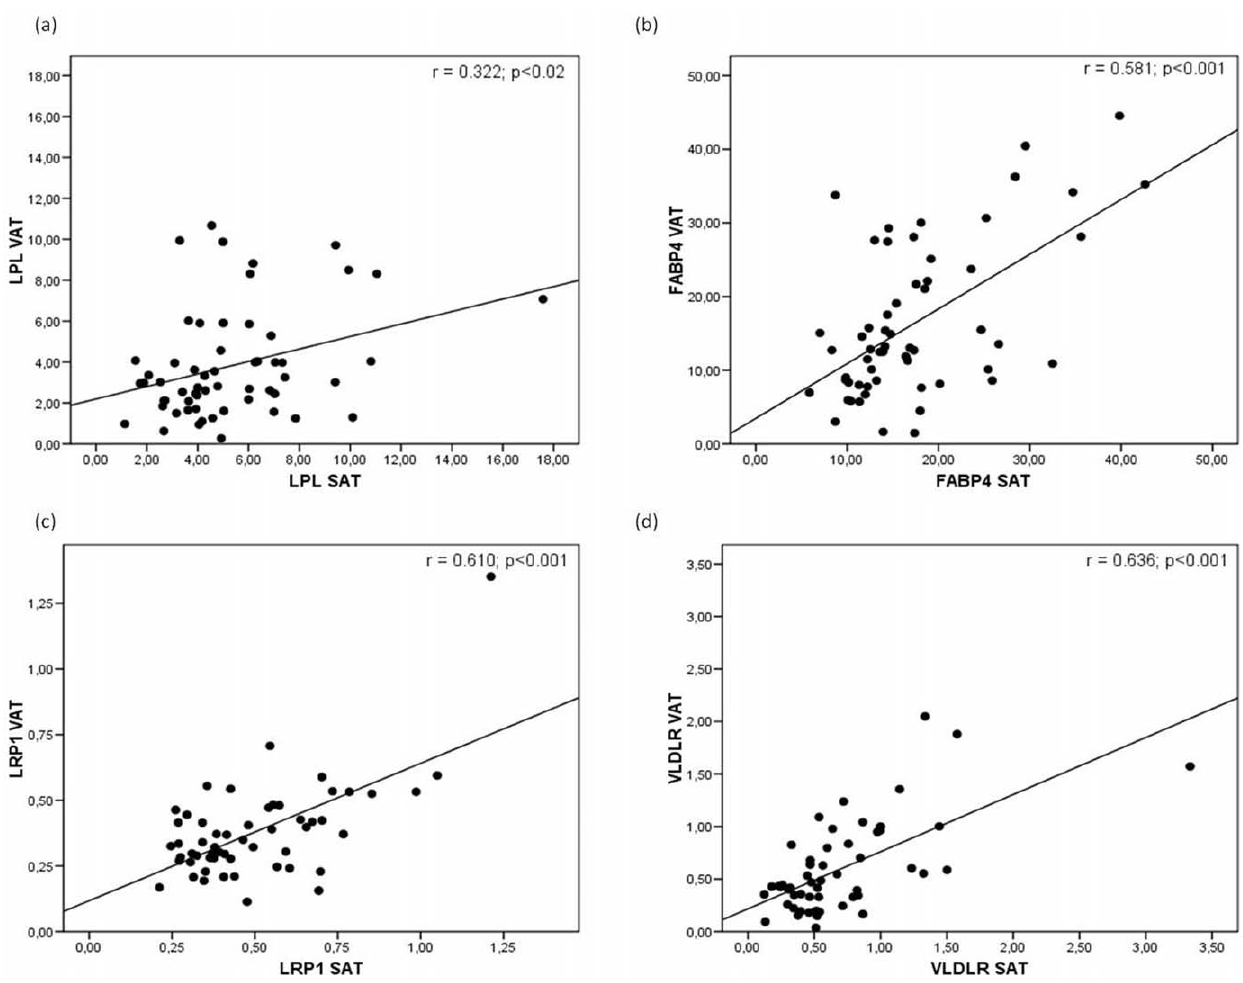
Figure 1. Linear relationship determined by Spearman’s correlation coefficient test between (a) LPL gene expression in VAT and LPL gene expression in SAT, (b) FABP4 gene expression in VAT and FABP4 gene expression in SAT, (c) LRP1 gene expression in VAT and LRP1 gene expression in SAT and (d) VLDLR gene expression in VAT and VLDLR gene expression in SAT. VAT, visceral adipose tissue; SAT, subcutaneous adipose tissue.